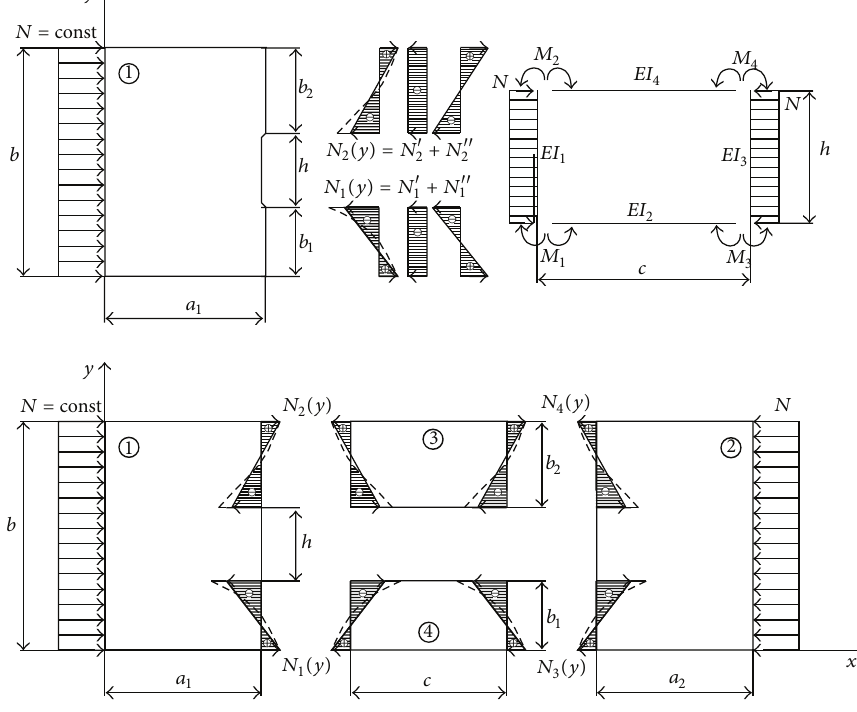
Figure 2: Model of planar state of stress of plate with rectangular